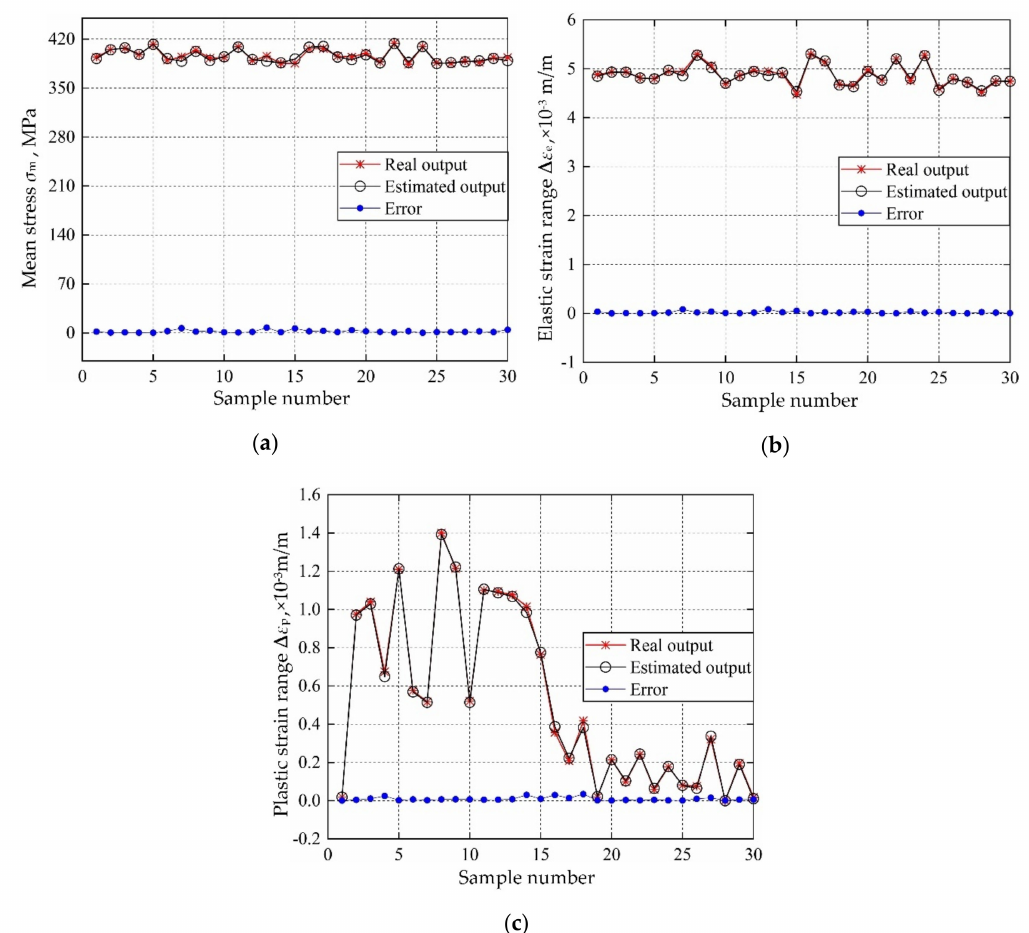
Figure 9. Prediction results of decomposed IKMs: ( a ) decomposed IKM-1, ( b ) decomposed IKM-2, ( c ) decomposed